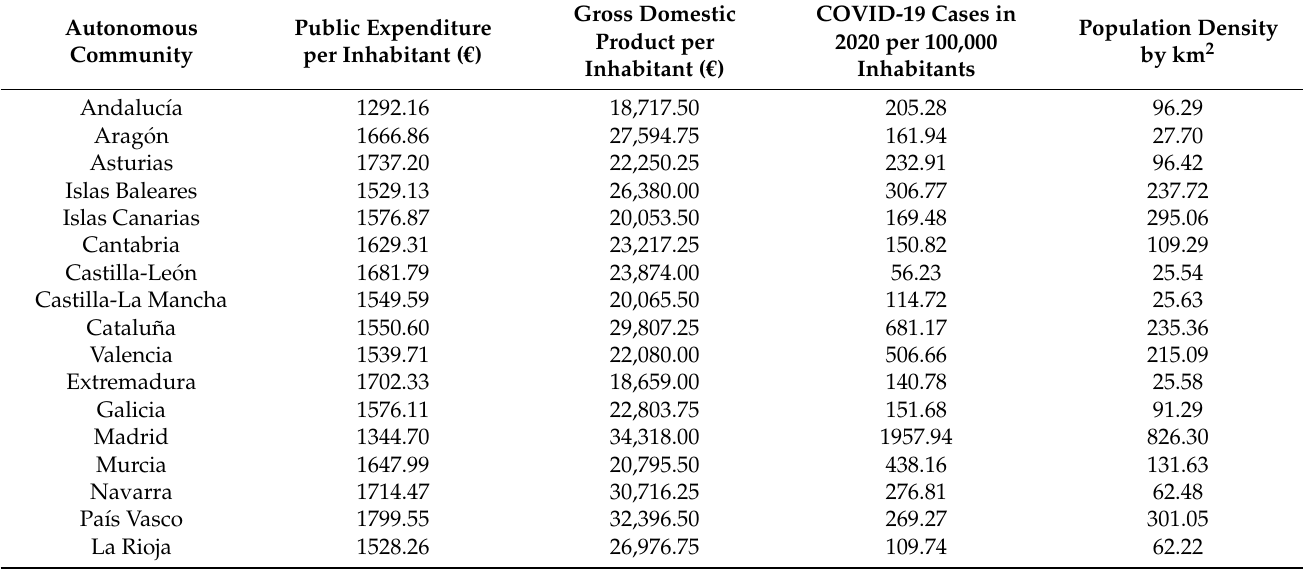
Table 4. Average by autonomous communities of the variables used in the cluster analysis for